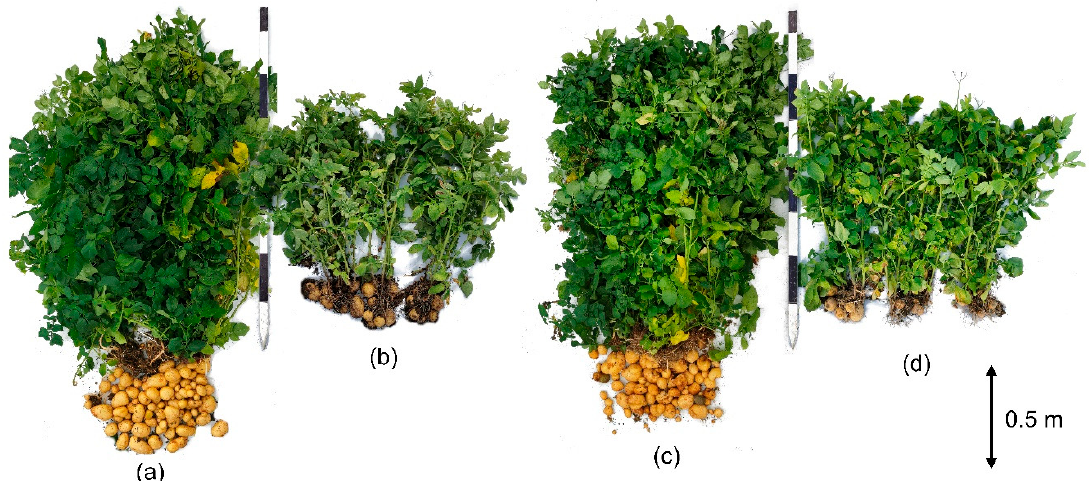
Figure 1. Potato plants and tubers (three per group) produced in the wood-fiber-based hydroponic system ( a , c ) and in the field ( b , d ).